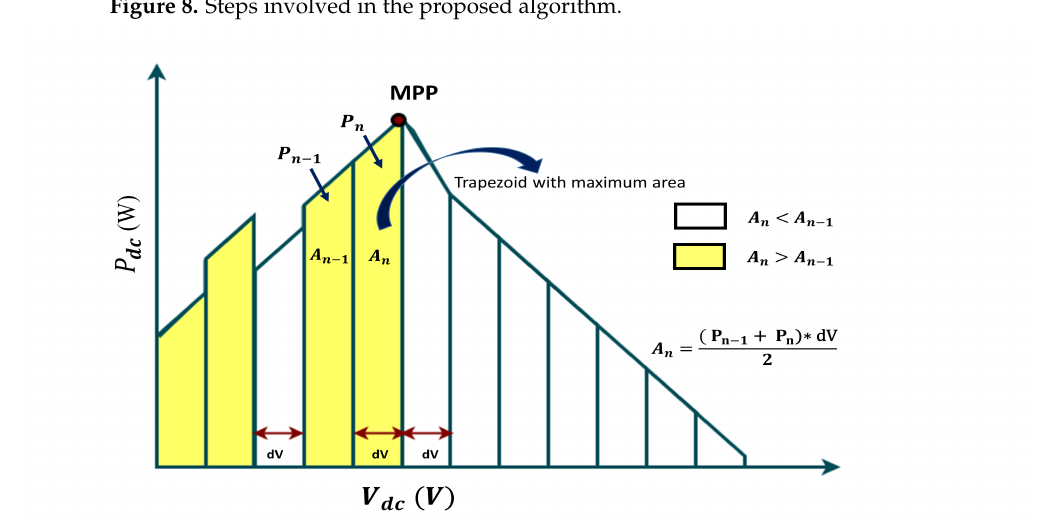
Figure 9. Concept of the proposed